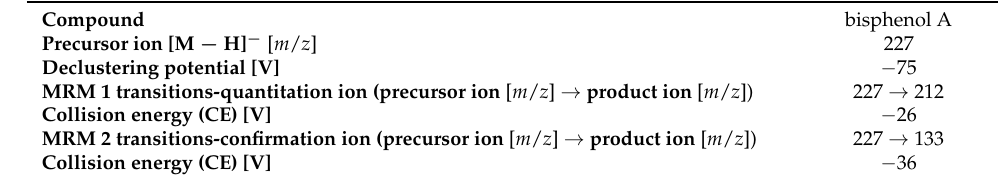
Table 1. Optimal MS/MS working conditions in MRM working mode for bisphenol A.